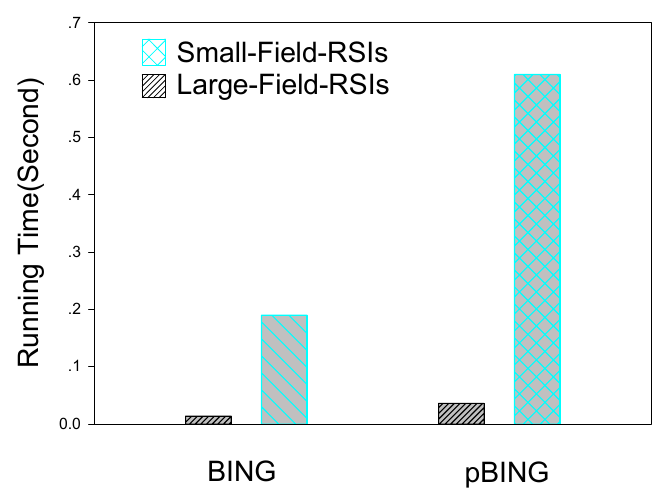
Figure 8. Average running time of the BING algorithm and the pBING algorithm on different